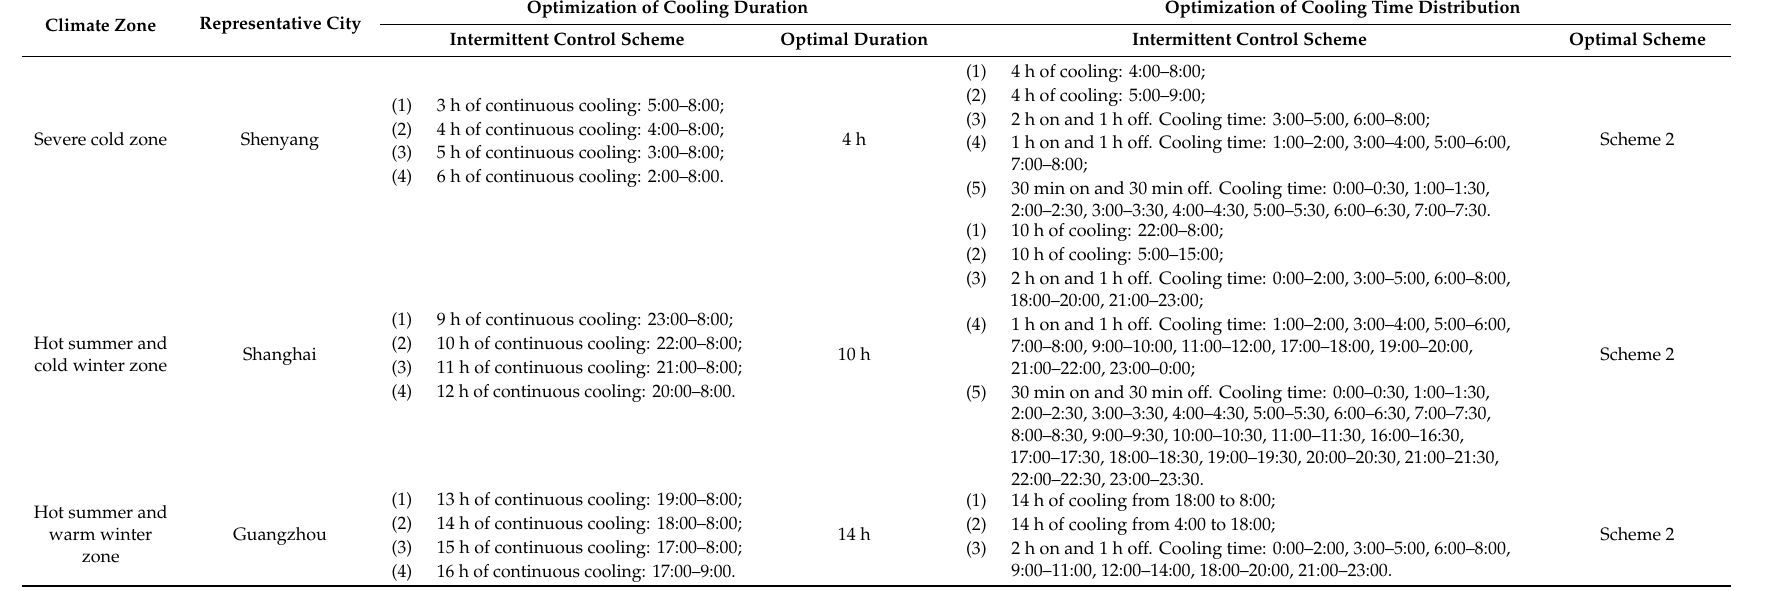
Table 8. Intermittent cooling control schemes and optimization results of other climate